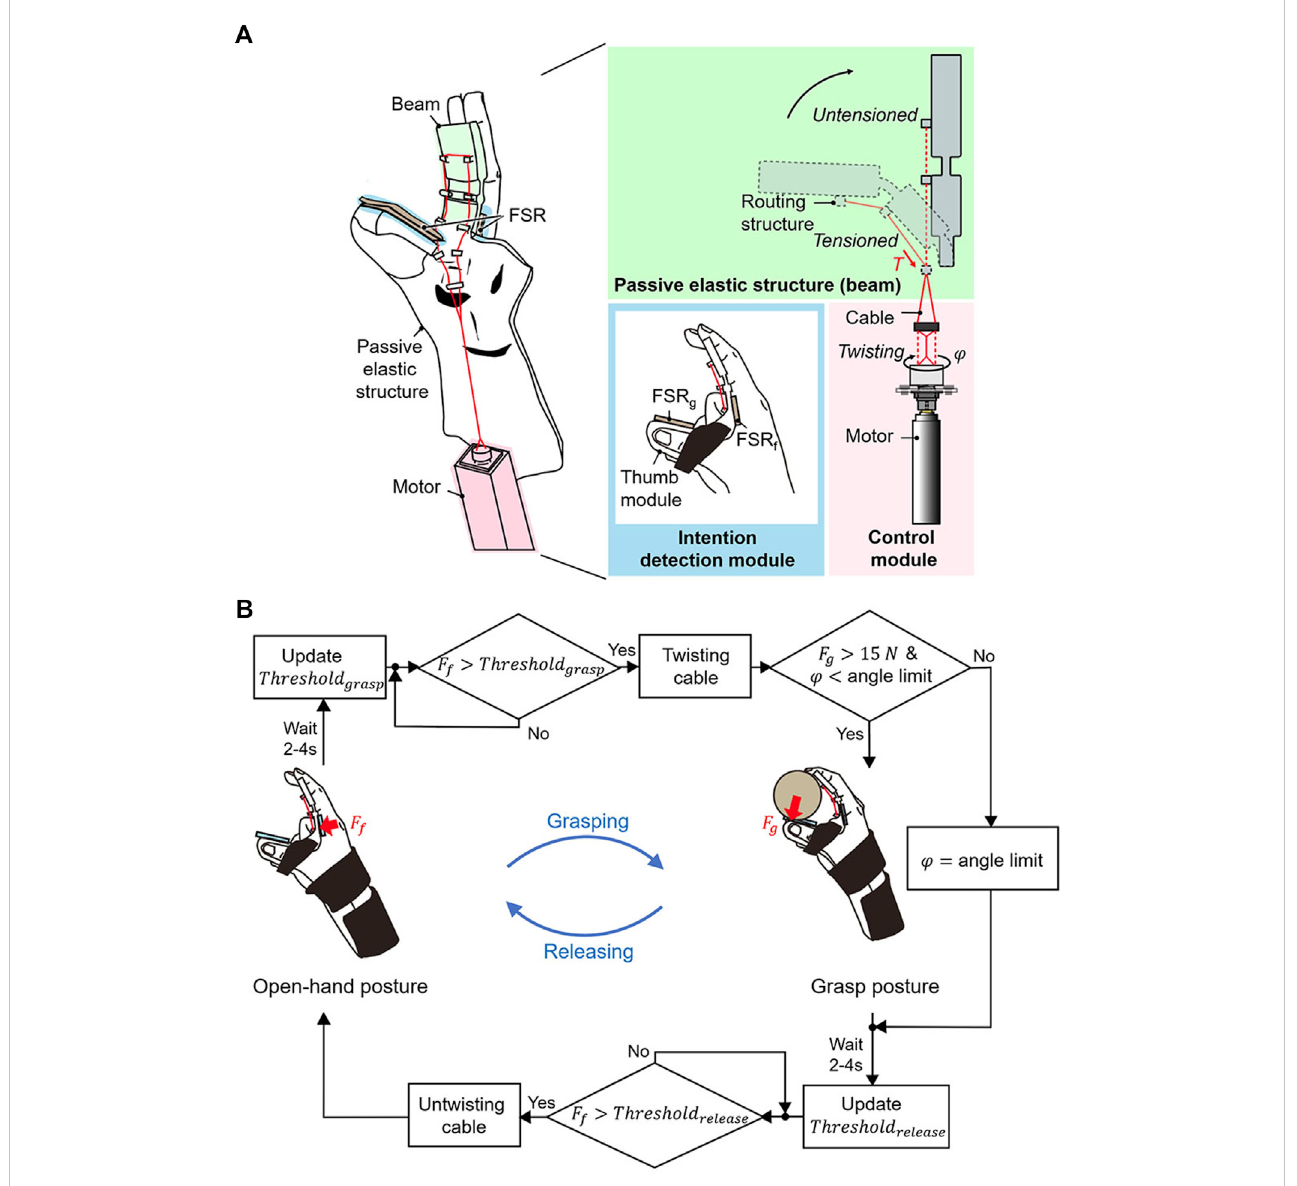
FIGURE 2 Design overview of the active hand orthosis. (A) The orthosis consists of a passive elastic structure for passive extension, a control module for active fl exion, and an intention detection module. The rotation angle ( φ ) of the motor is adjusted to twist the cable, which generates the assistive force ( T ). The assistive force is applied to routing structures of the beam. Two force-sensing resistors (FSR g , FSR f ) are used as the intention detection module. (B) Working principle of the orthosis based on user intention. The grasping and releasing tasks are initiated when the user applies a fl exion force ( F f ) over the pre-set Threshold grasp and Threshold release . A grasping task is achieved by rotating the motor from the initial angle, which was set when the cable was completely untwisted, to the holding angle when a grip strength ( F g ) reaches a 15 N. The releasing task is done by rotating the motor from the holding angle to the initial